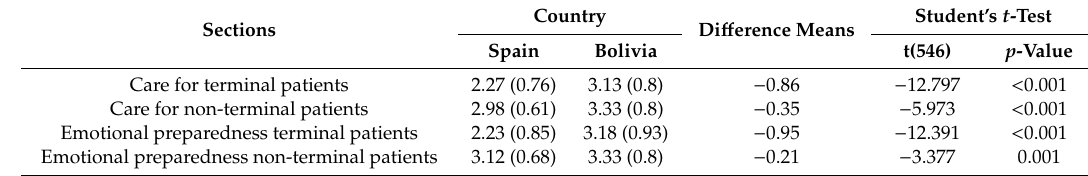
Table 2. Perceived emotional preparation and ability to care for terminal and non-terminal patients.